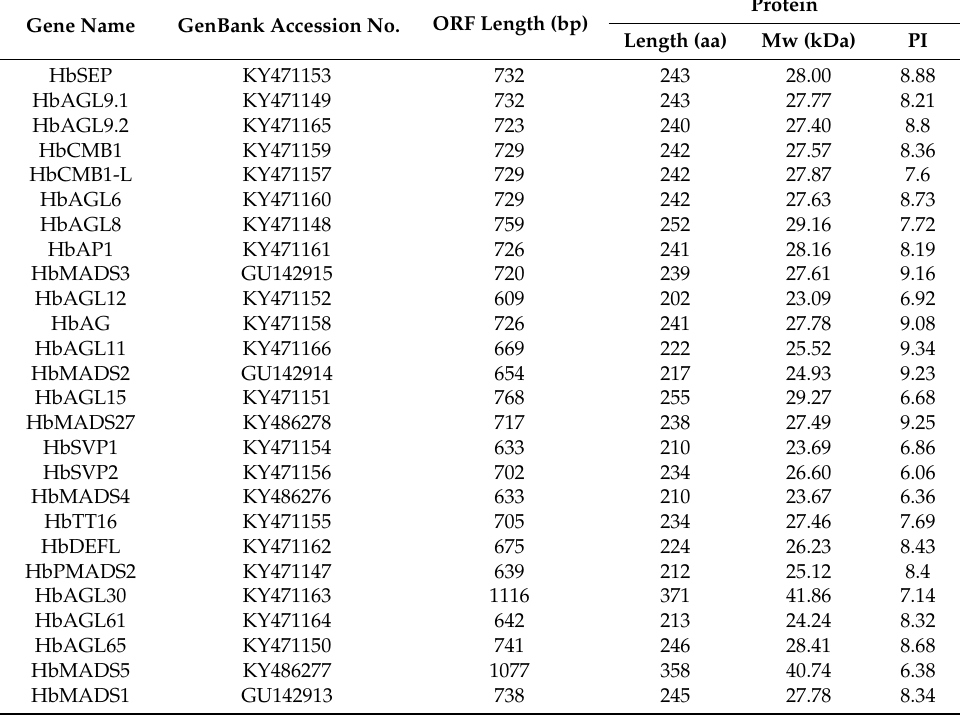
Table 1. Characteristics of HbMADS-box genes family in Hevea brasiliensis Müll.